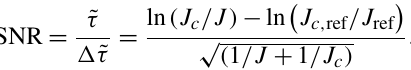
Figure 5. The S c approximation in Eq. (15) as a function of the true values of S c . For S c = 4 · 10 18 molec.cm − 2 , the proposed approximation underestimates the true value of S c by less than 2 · 10 17 molec.cm − 2